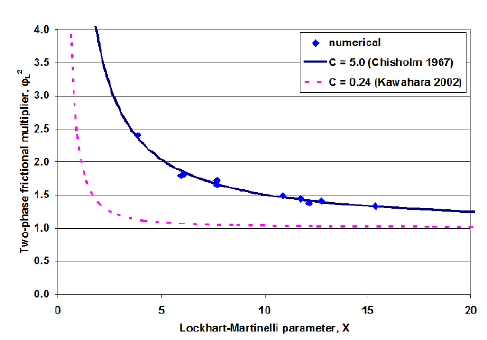
Figure 14. Two-phase frictional pressure drop by Lockhart- Martinelli correlation